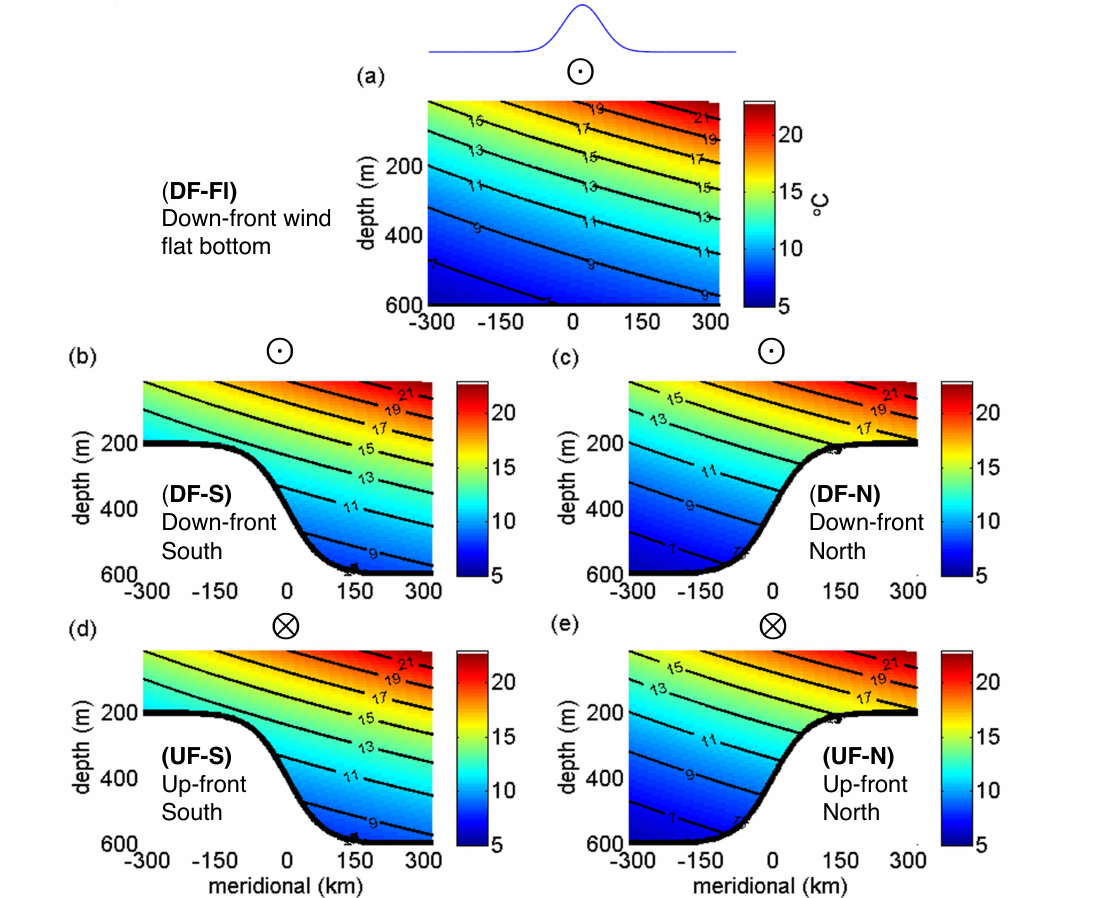
Figure 2. Schematic overview of the model configuration for the five simulations described in Table 1. Panels ( a – e ) correspond to experiments (1)–(5). Experiment ID is indicated in each panel. Colors and contours show the zonally-uniform initial temperature profile. The temperature is relaxed to these initial values at the northern and southern boundaries. The thick black curve marks the bathymetry, while the circle over each panel marks the wind orientation: down-front (dots) or up-front (crosses). The blue curve on the top of panel ( a ) shows the surface wind stress profile, with a peak value τ 0 = 0.05 N m − 2